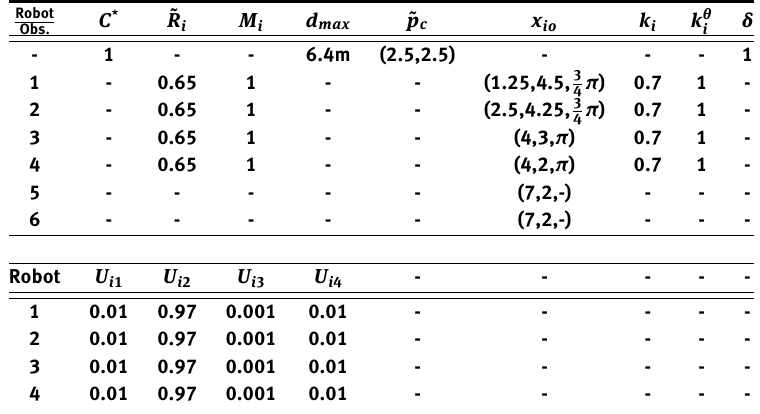
Table 7. Table of Experiment 2 parameters.